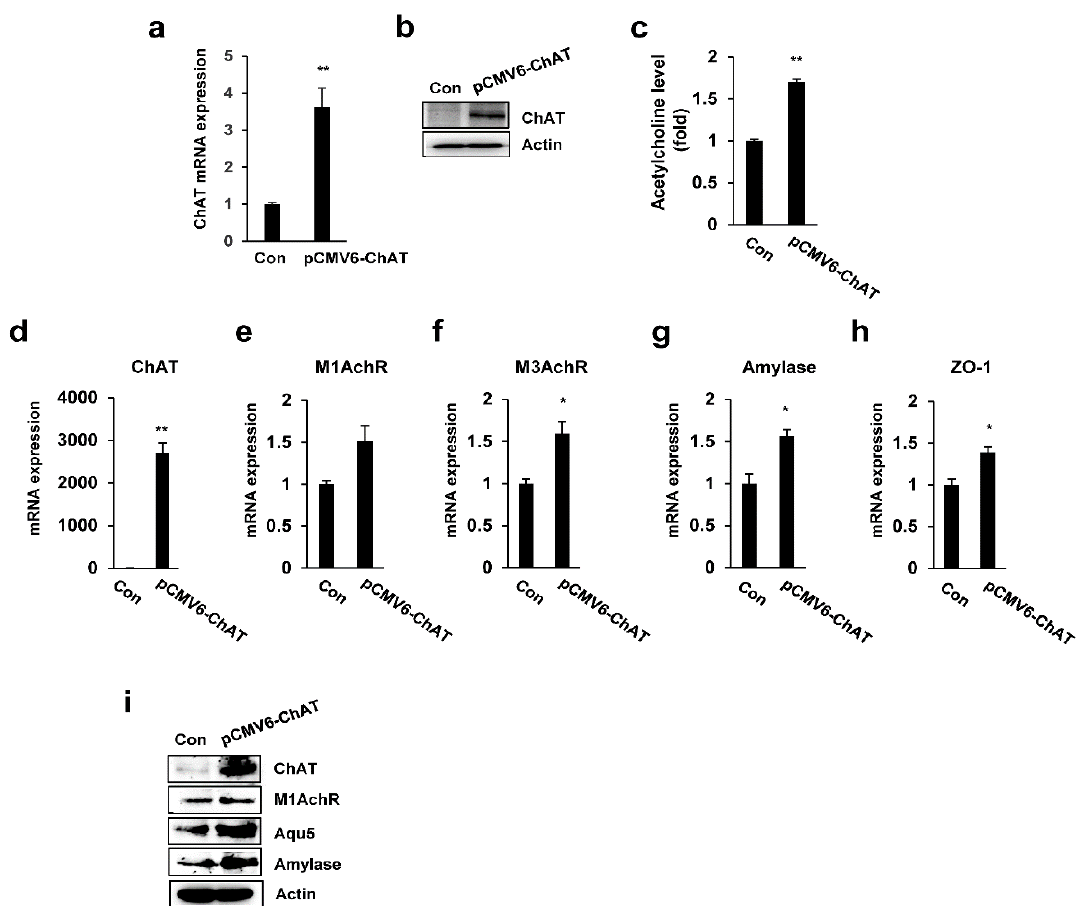
Figure 4. Overexpression of ChAT restored acetylcholine levels and improved salivary gland marker expression. ( a – c ) PSGC kl -/- were transfected with the ChAT expression plasmid (pCMV6-ChAT). After transfection, Western blotting and qRT-PCR were conducted to assess the ChAT expression level. The cellular acetylcholine concentration was also measured. ( d – i ) PSGC kl -/- cells were transfected with the ChAT expression plasmid (pCMV6-ChAT). After transfection, Western blotting and qRT-PCR were conducted to assess the ChAT and salivary gland marker expression levels. Data are presented as the mean ± SD. * p < 0.05, ** p < 0.01.